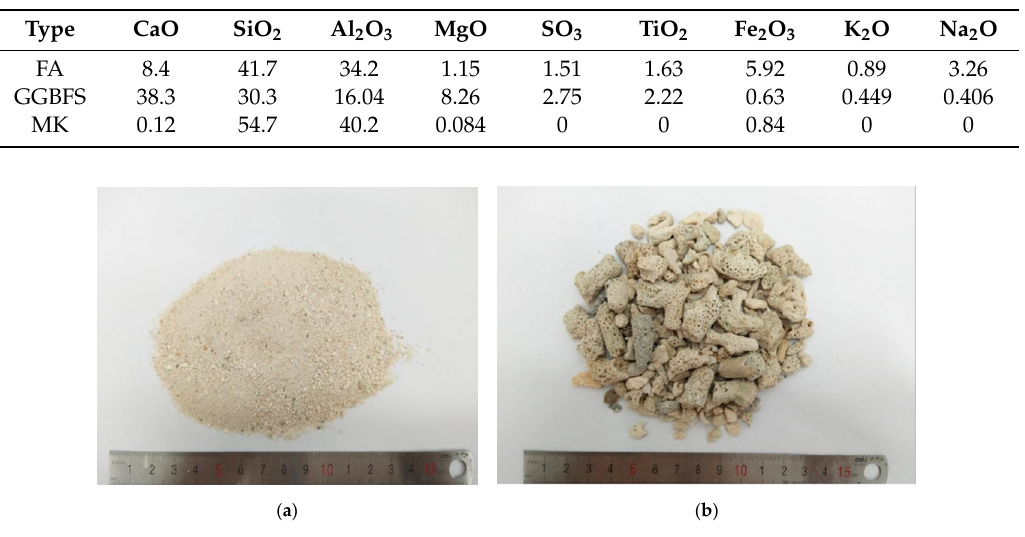
Figure 1. Coral aggregates used in the test: ( a ) Coral sand; and, ( b ) Coral coarse aggregate.